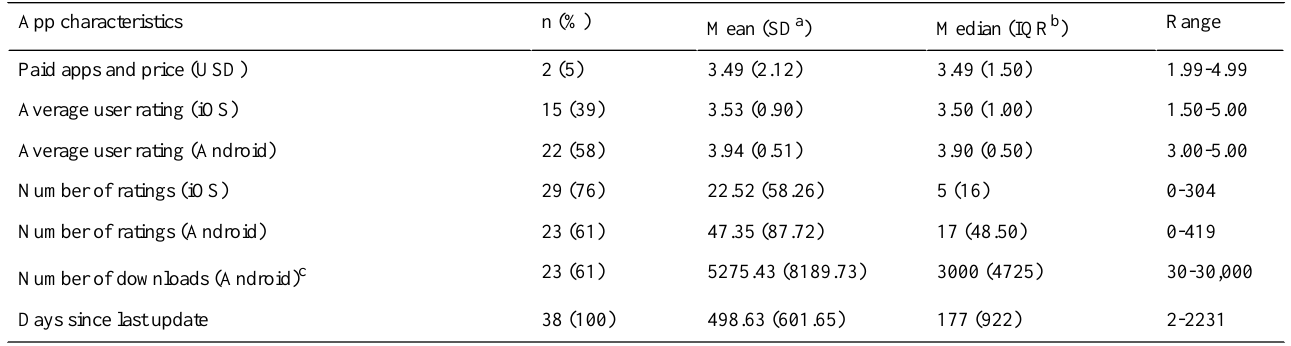
Table 1. Overview general app